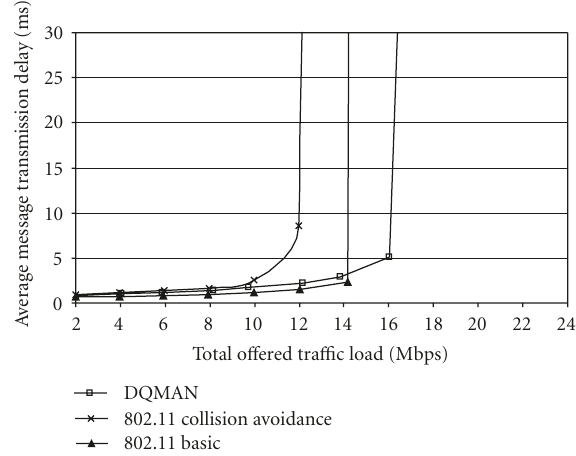
Figure 13: Average Message Transmission Delay DQMAN versus